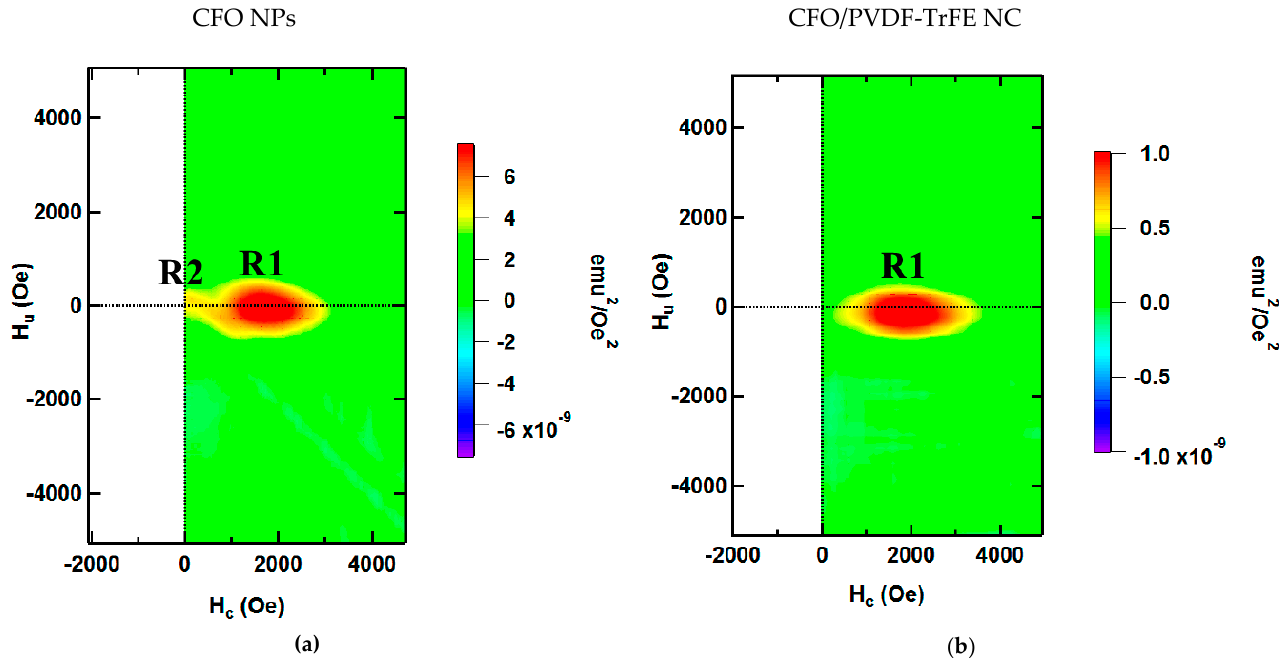
Figure 5. First order reversal curves (FORC) diagram for ( a ) CFO NPs and ( b ) PVDF-TrFE/CFO nanocomposite sample.